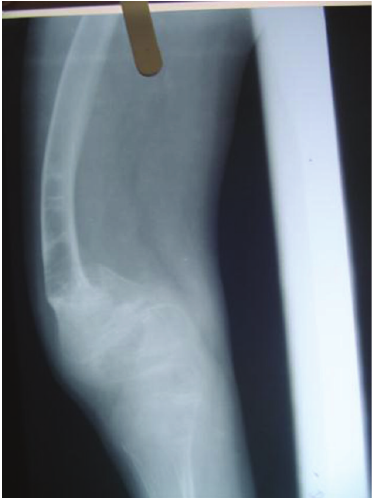
Figure 6: Radiograph of the lower limbs showing bowing of the femur, with widening of the metaphases.